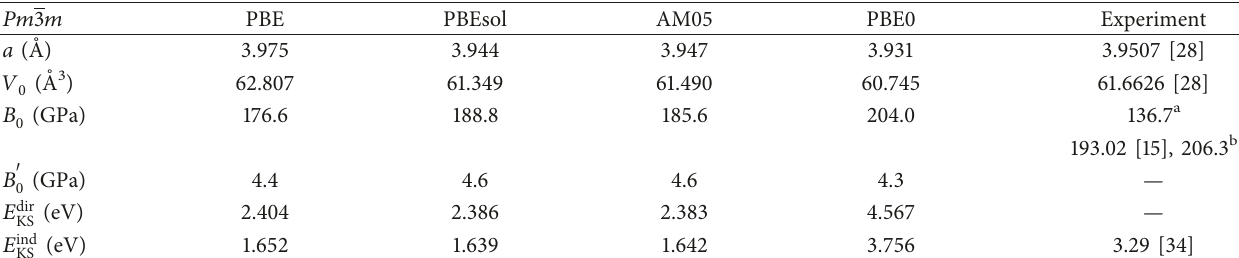
3 in comparison to experimental data.